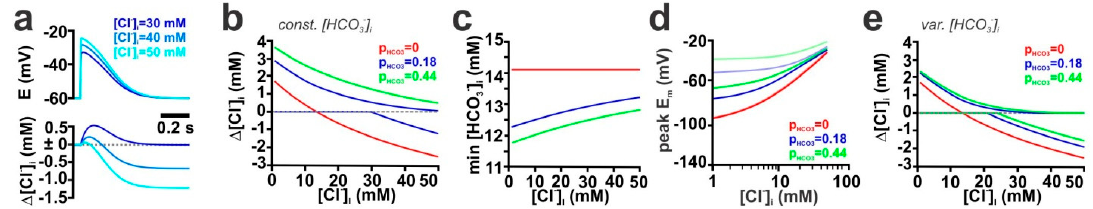
Figure 5. Influence of the relative HCO3 ⁻ conductivity (P HCO3 ) on GABA-induced membrane depolarization and [Cl ⁻ ] i transients in an isolated dendrite. Activity-dependent decline in [HCO3 ⁻ ] i reduces GABAergic depolarization and affects [Cl ⁻ ] i changes. ( a ) Time course of E m and [Cl ⁻ ] i changes ( Δ [Cl ⁻ ] i ) upon a single synaptic stimulation (g GABA = 7.89 nS, τ = 37 ms, P HCO3 = 0.18, [HCO3 ⁻ ] i = 14.1 mM) at initial [Cl ⁻ ] i of 30 mM (dark blue), 40 mM (middle) and 50 mM (light blue). Note that at intermediate [Cl ⁻ ] i ,a synaptic stimulus can induce biphasic [Cl ⁻ ] i responses. ( b ) Dependency between Δ [Cl ⁻ ] i and [Cl ⁻ ] i upon a single synaptic stimulation (g GABA = 7.89 nS, τ = 37 ms, [HCO3 ⁻ ] i = 14.1 mM) for different P HCO3 . Note the biphasic responses for P HCO3 of 0.18 (represented by the two blue lines) and that at higher P HCO3 the [Cl ⁻ ] i fluxes are shifted towards influx even for high initial [Cl ⁻ ] i . ( c ) Dependency between [HCO3 ⁻ ] i and [Cl ⁻ ] i upon a single synaptic stimulation using a model with dynamic [HCO3 ⁻ ] i (g GABA = 7.89 nS, τ = 37 ms, initial [Cl ⁻ ] i = 30 mM, initial [HCO3 ⁻ ] i = 14.1 mM). ( d ) Dependency between peak depolarization and [Cl ⁻ ] i upon a single synaptic stimulation (conditions as in c) at different P HCO3 . Note that the implementation of dynamic [HCO3 ⁻ ] i (plain lines) massively reduces peak depolarization as compared to conditions with static [HCO3 ⁻ ] i (shaded lines). ( e ) Dependency between [Cl ⁻ ] i changes and [Cl ⁻ ] i upon a single synaptic stimulation (conditions as in c ). Dual lines with identical colors represent biphasic responses. Note the reduced [Cl ⁻ ] i changes with dynamic [HCO3 ⁻ ] i as compared to static [HCO3 ⁻ ] i conditions (shown in b) and that the [Cl ⁻ ] i at which Cl ⁻ influx changes to Cl ⁻ efflux was shifted to lower [Cl ⁻ ] i .